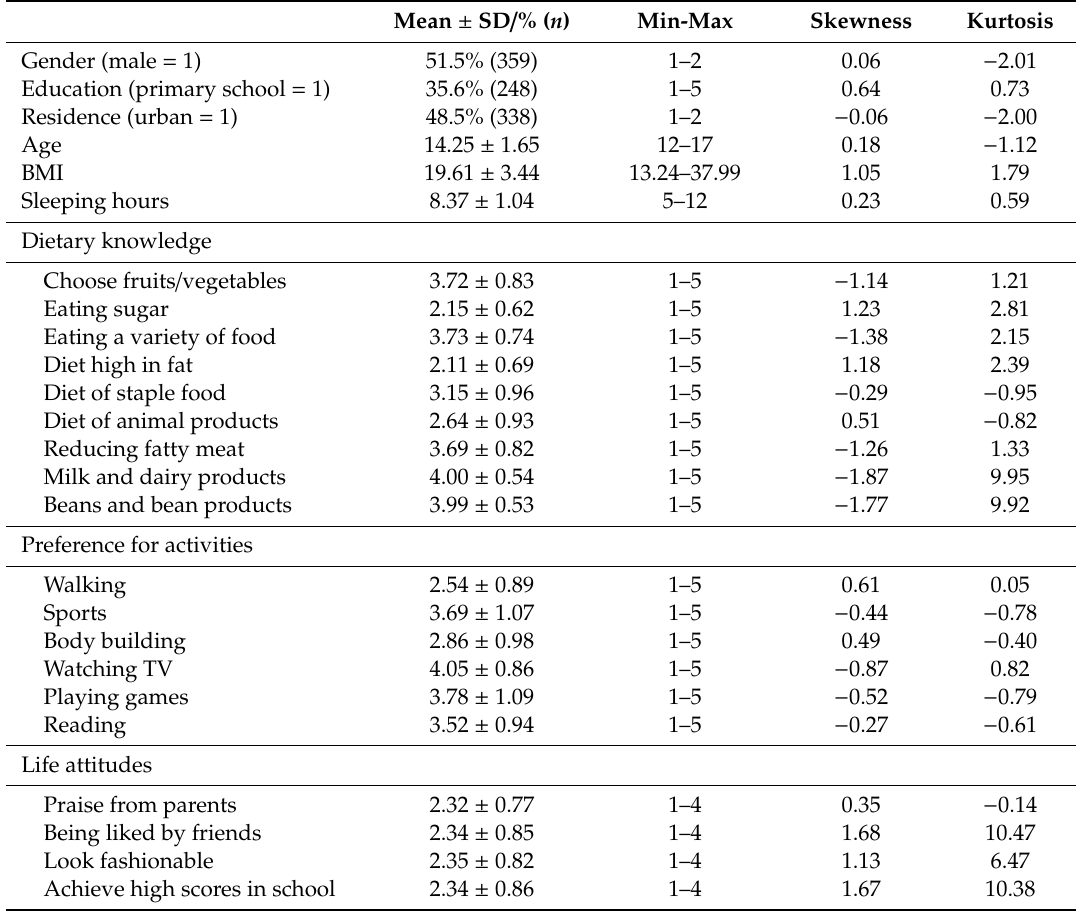
Table 1. Descriptive statistics for the total sample ( n =